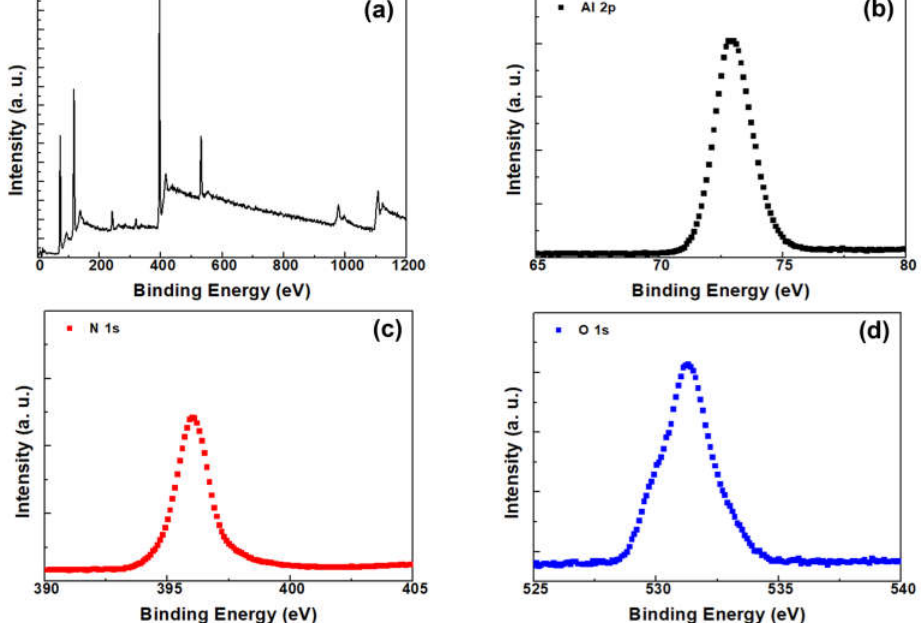
Figure 2. XPS spectra of PEALD AlN film; ( a ) wide-scan, ( b ) Al 2p, ( c ) N 1s, and ( d ) O1s of the PEALD AlN film.